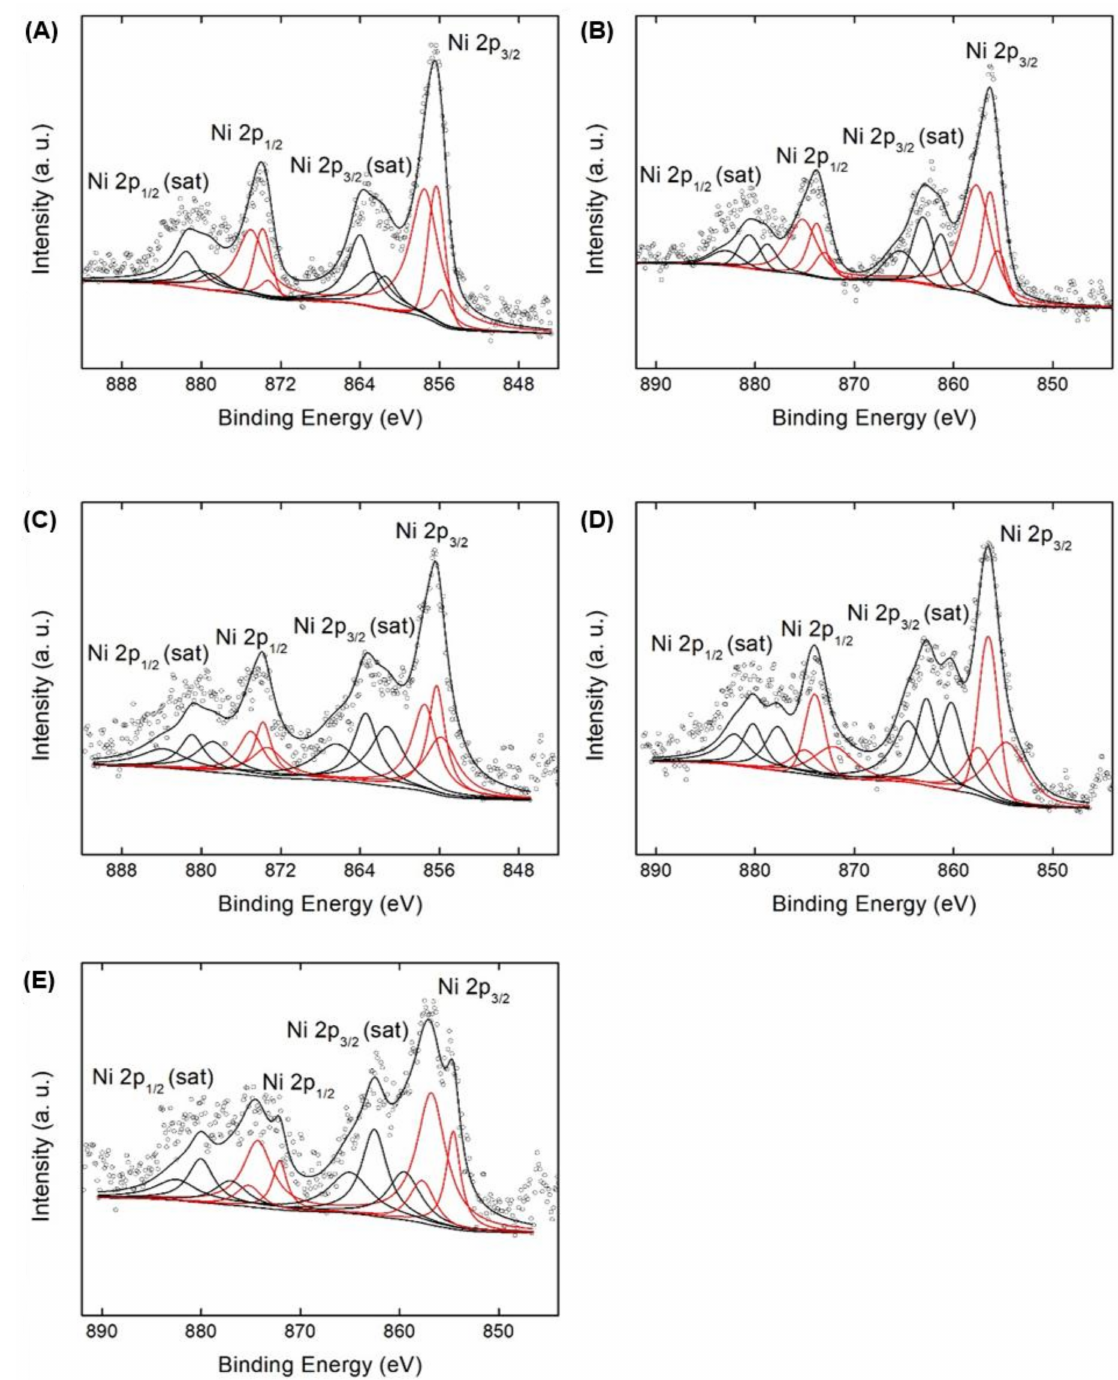
Figure 4. XPS spectra of Ni 2p obtained from ( A ) NiOx / SA-001, ( B ) NiOx / SA-007, ( C ) NiOx / SA-028, ( D ) NiOx / SA-047, and ( E ) NiOx /